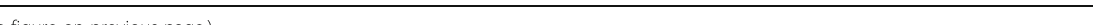
(See figure on previous page.) Fig. 9 Dinoflagellate cysts from the Chiba composite section. Max. dia. = maximum diameter. EF = England Finder reference. a – c cyst of Protoceratium reticulatum , ventral view at upper, slightly lower, and mid-foci; b showing characteristic rounded adapical margin of detached operculum, also in ventral view, within cyst; central body max. dia. 40 μ m; sample TB2 00, slide 3 (10 μ m) MJH, EF Q9/4. d – f Operculodinium ? longispinigerum , view uncertain; note finely granulate central body surface, solid tapering processes, somewhat flexuous with finely granulate surfaces distally and with circular bases; central body max. dia. 33 μ m; sample TB 58, slide 1 (10 μ m), EF J10/1. g Brigantedinium cariacoense , ventral view at mid-focus on archeopyle; cyst max. dia. 38 μ m; sample TB 34,